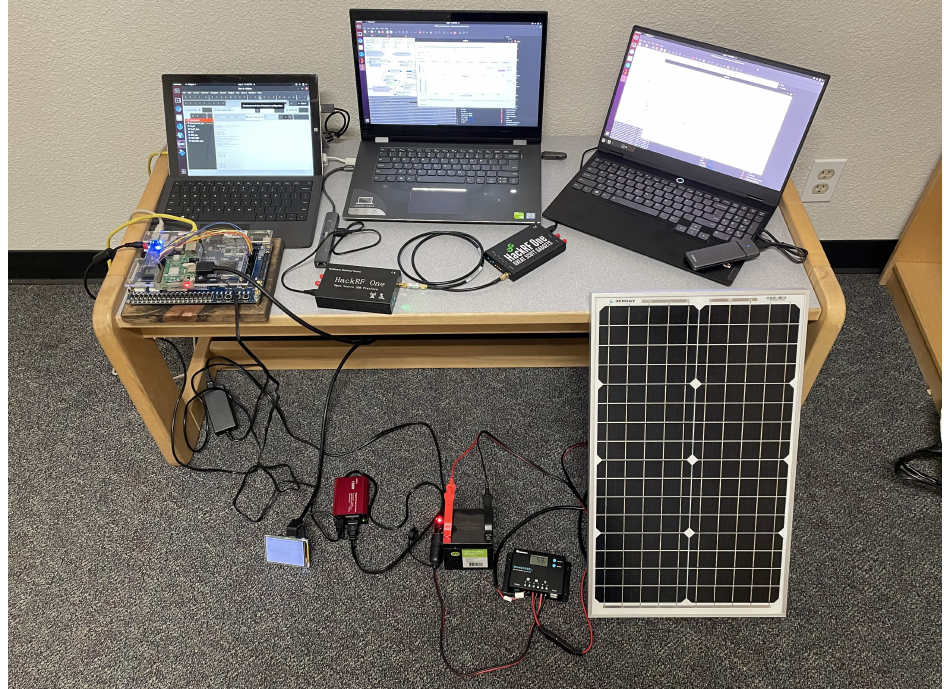
Figure 9. Layout of complete demonstration project. The leftmost laptop controls the DE2-115 FPGA board; the middle laptop controls the transmitting HackRF One SDR; the rightmost laptop controls the receiving HackRF One